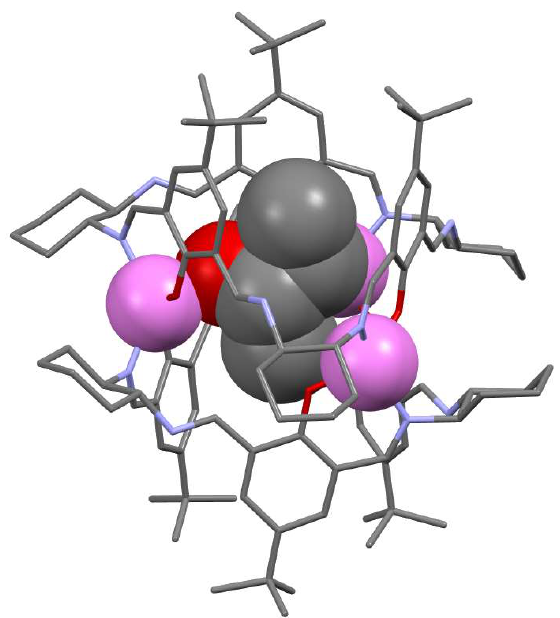
Figure 19. Metal-organic cage based on two macrocyclic units of 8 . Zinc atoms (violet) and ( S )-2-butanol are in spacefill representation.